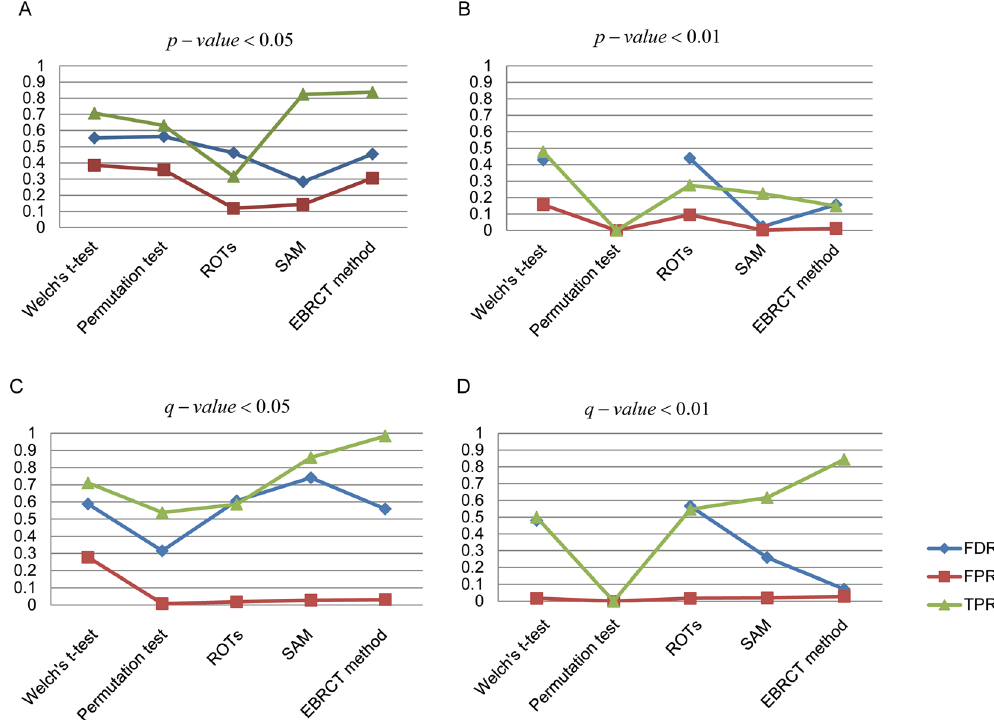
Figure 1. Line charts of FDR, FPR and TPR changes for five different DEP detection methods. ( A ) p-value < 0.05 when using D1, ( B ) p-value < 0.01 when using D1, ( C ) q-value < 0.05 when using D2, ( D ) q-value < 0.01 when using